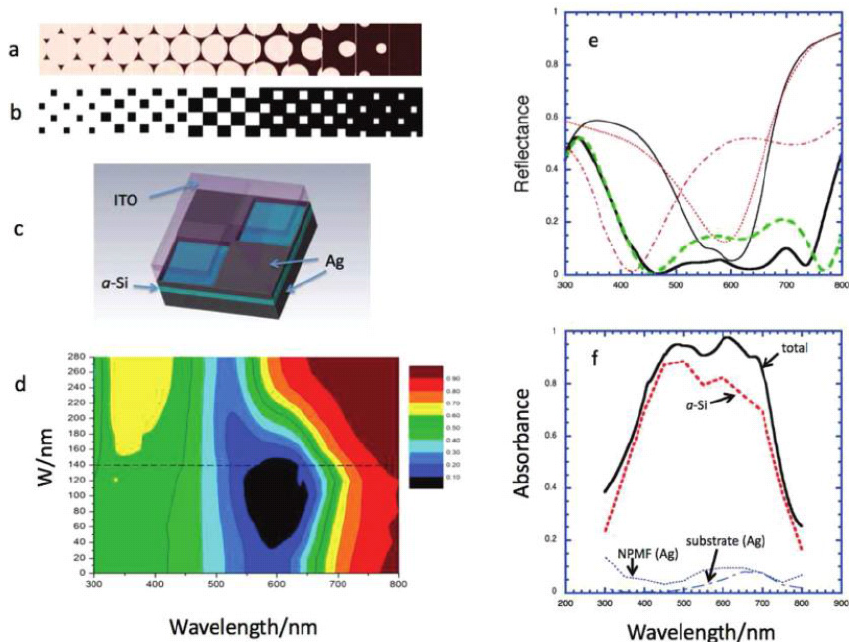
Figure 5. ( a ) Structures evolving from honeycomb arrays of quasi-triangular islands, to hexagonal arrays of circular holes, to a solid film. ( b ) Checkerboard series. ( c ) The in-plane unit cell of our optimized checkerboard super-absorber structure. ( d ) The color-encoded map of R vs W and λ . ( e ) and ( f ) are the reflectance and total absorbance spectrum. Reprinted with permission from [42]. Copyright © 2011 American Chemical